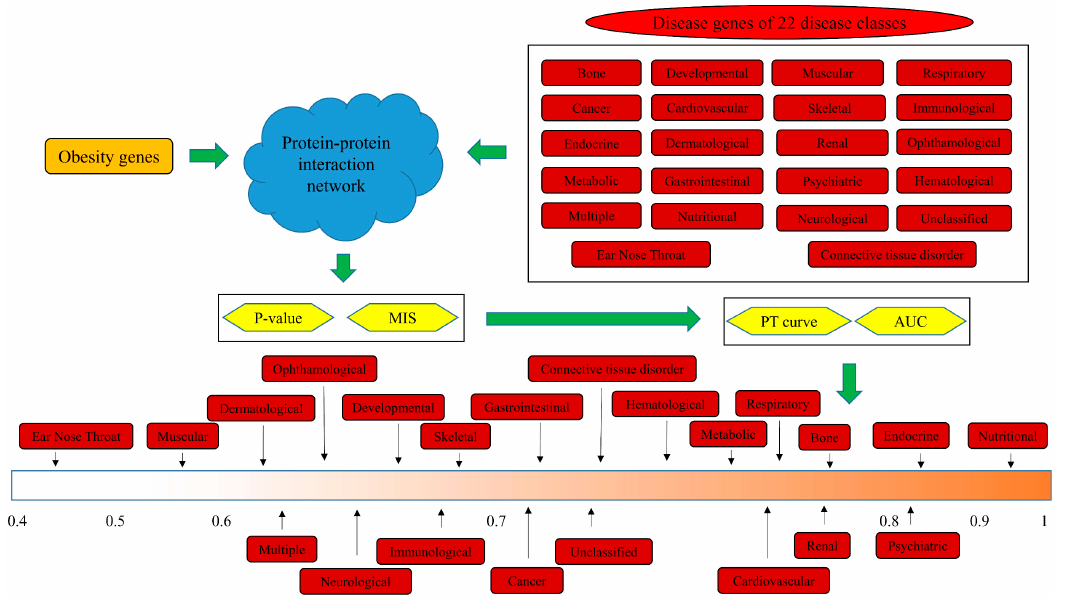
Figure 1. Flowchart of the investigation procedures of this